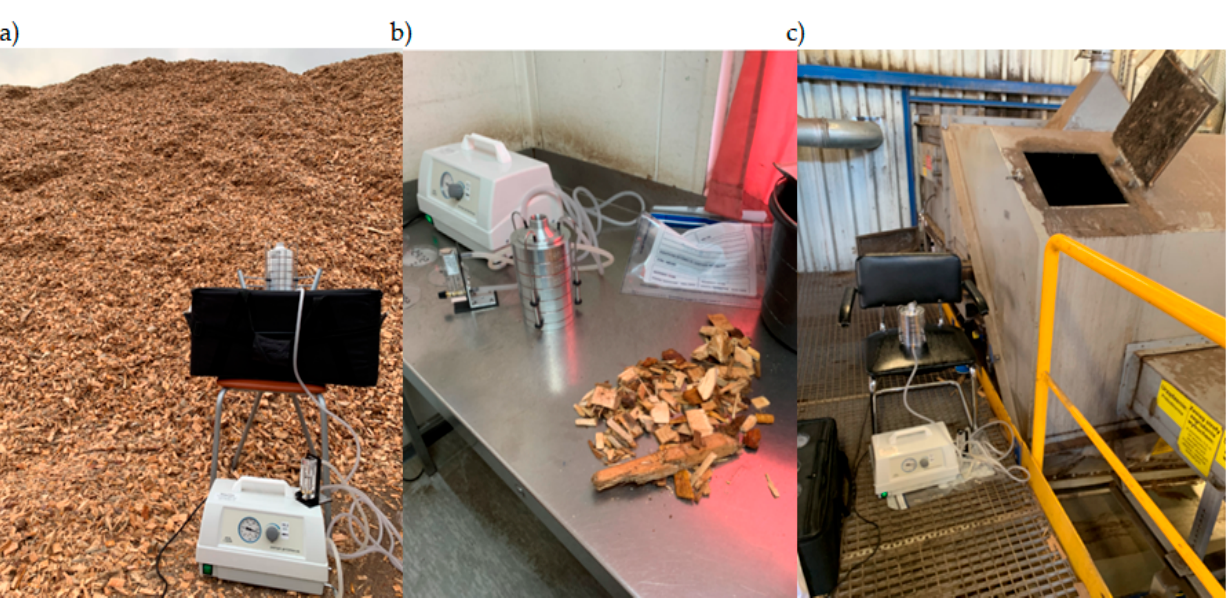
Figure 1. The six-stage Andersen cascade impactor used during measurements in ( a ) unloading yard, ( b ) biomass analysis laboratory, and ( c ) weight conveyor. Table 2. Sampling points in the power plant.